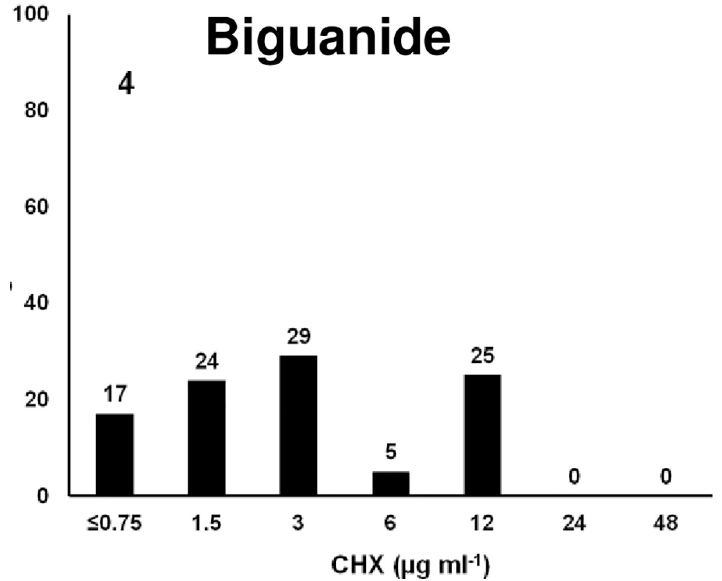
Fig 4. Frequencies of the MICs of 88 MDR Salmonella isolates to the biguanide, Chlorhexidine, CHX. X-axis is the 2-fold increase of biocide concentration; y-axis is percentage of isolates susceptible at each concentration of CHX.